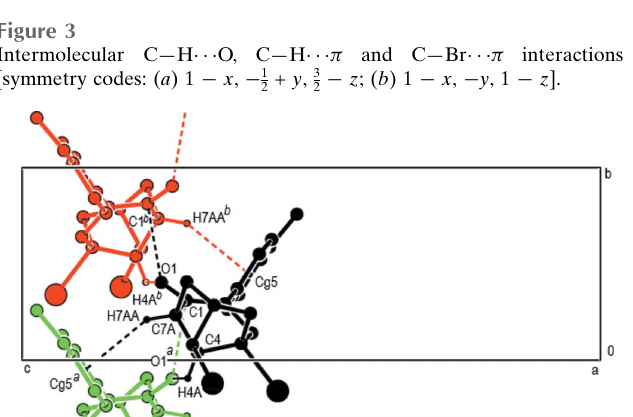
Figure 3 Intermolecular C—H (cid:2)(cid:2)(cid:2) O, C—H (cid:2)(cid:2)(cid:2) (cid:2) and C—Br (cid:2)(cid:2)(cid:2) (cid:2) interactions [symmetry codes: ( a ) 1 (cid:3) x , (cid:3) 1